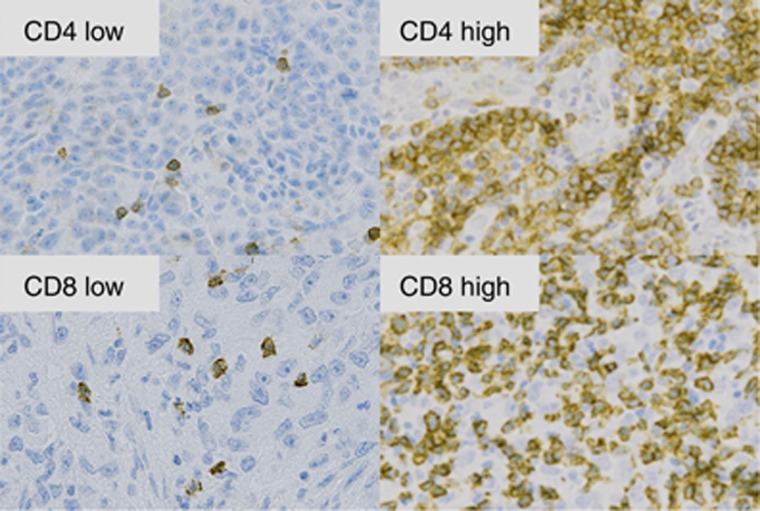
Representative low and high T-cell densities (× 400) magnification: CD4+ and CD8+ cells.